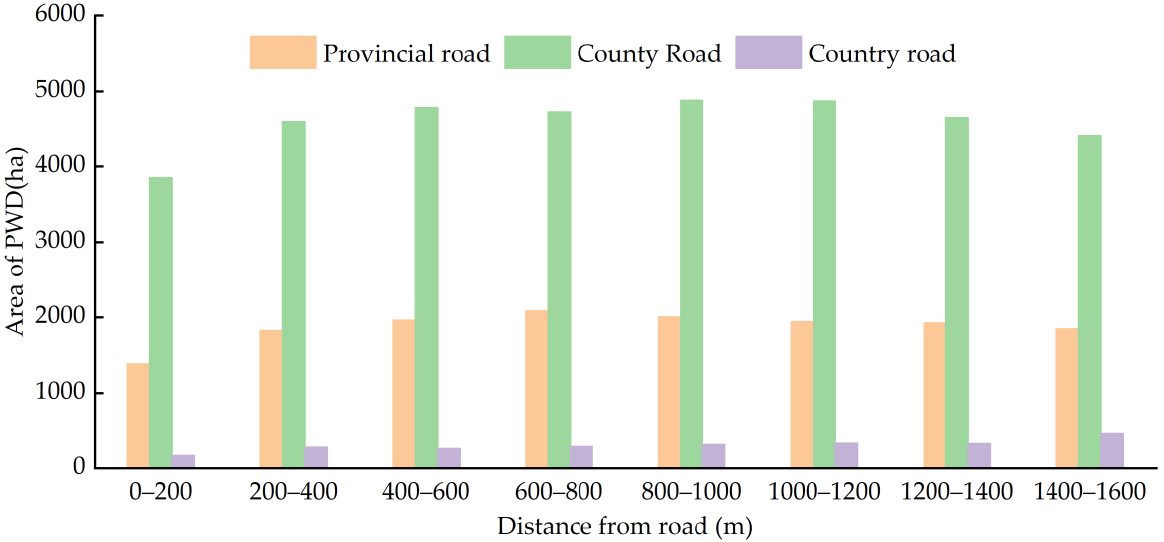
Figure 11. Relationship between occurrence area of PWD and road distance in Anhui province in 2020.